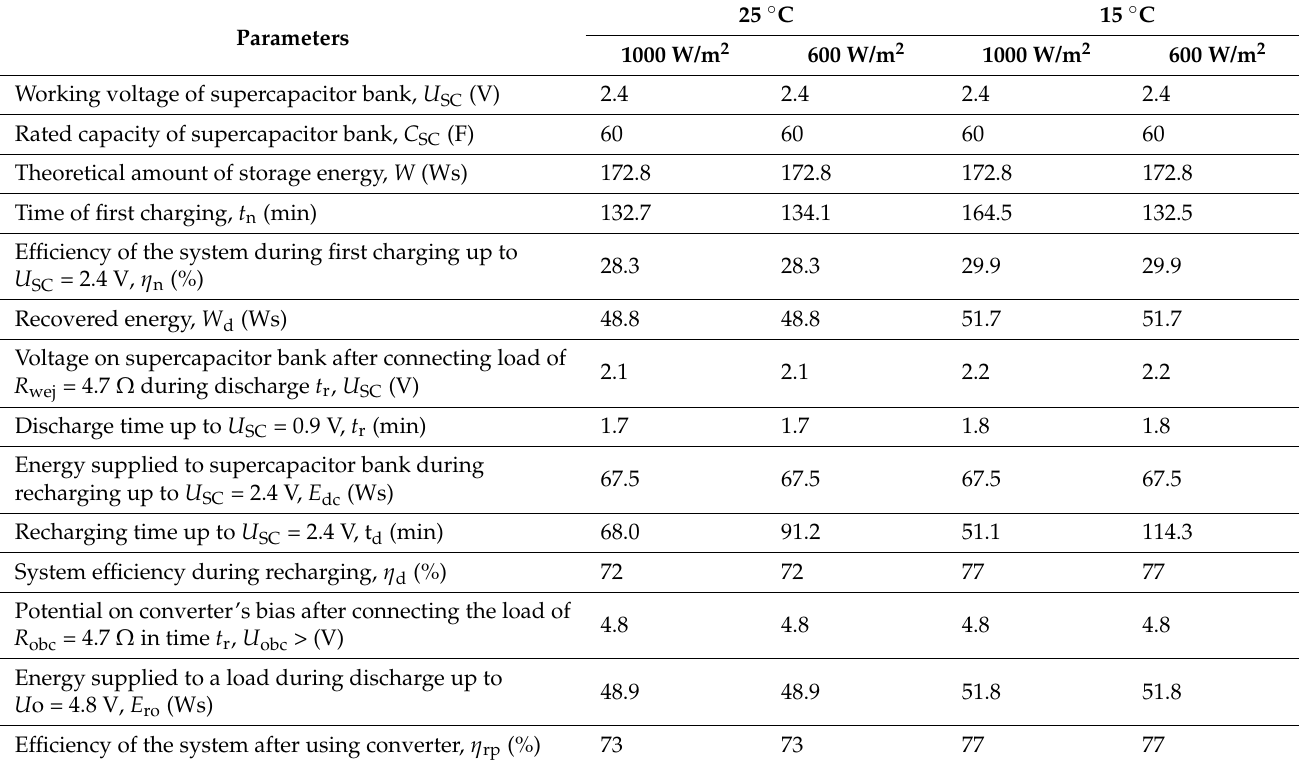
Table 3. Summary of selected electrical parameters of investigated energy storage system at various laboratory